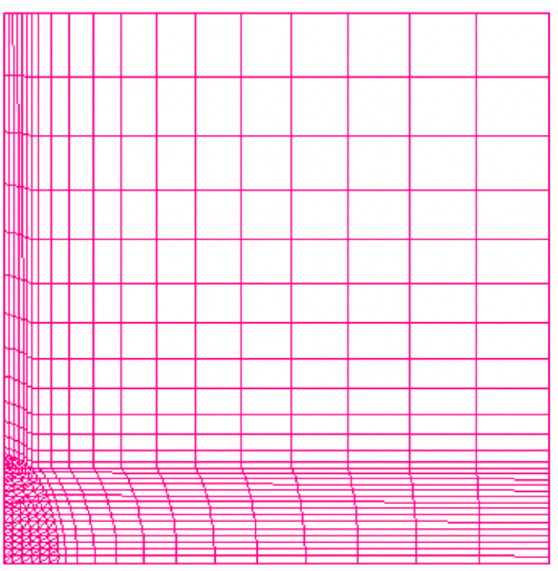
Figure 6 Two-dimensional elliptical delaminations (top view).